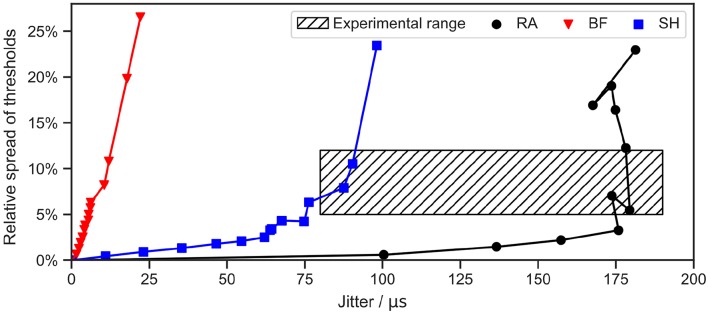
Stochasticity of ANF models with a Gaussian noise current term. Jitter and relative spread of threshold were measured for different values of knoise. A monophasic 50 μs cathodic current pulse was applied in each simulation. Threshold and latency were measured 100 and 500 times, respectively, for each data point. “RA,” “BF,” and “SH” denote the Rattay, Briaire-Frijns and Smit-Hanekom models, respectively. The experimental range was summarized from a series of animal experiments, including van den Honert and Stypulkowski (1984), Javel et al. (1987), Dynes (1996), Miller et al. (1999), and Cartee et al. (2000).